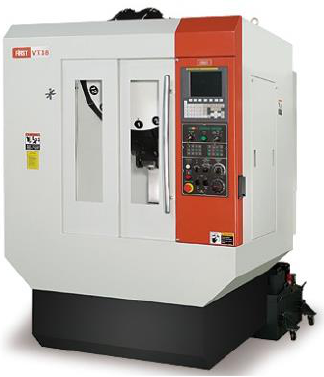
Figure 1. Procedure of fuzzy control for feed rate scheduling.